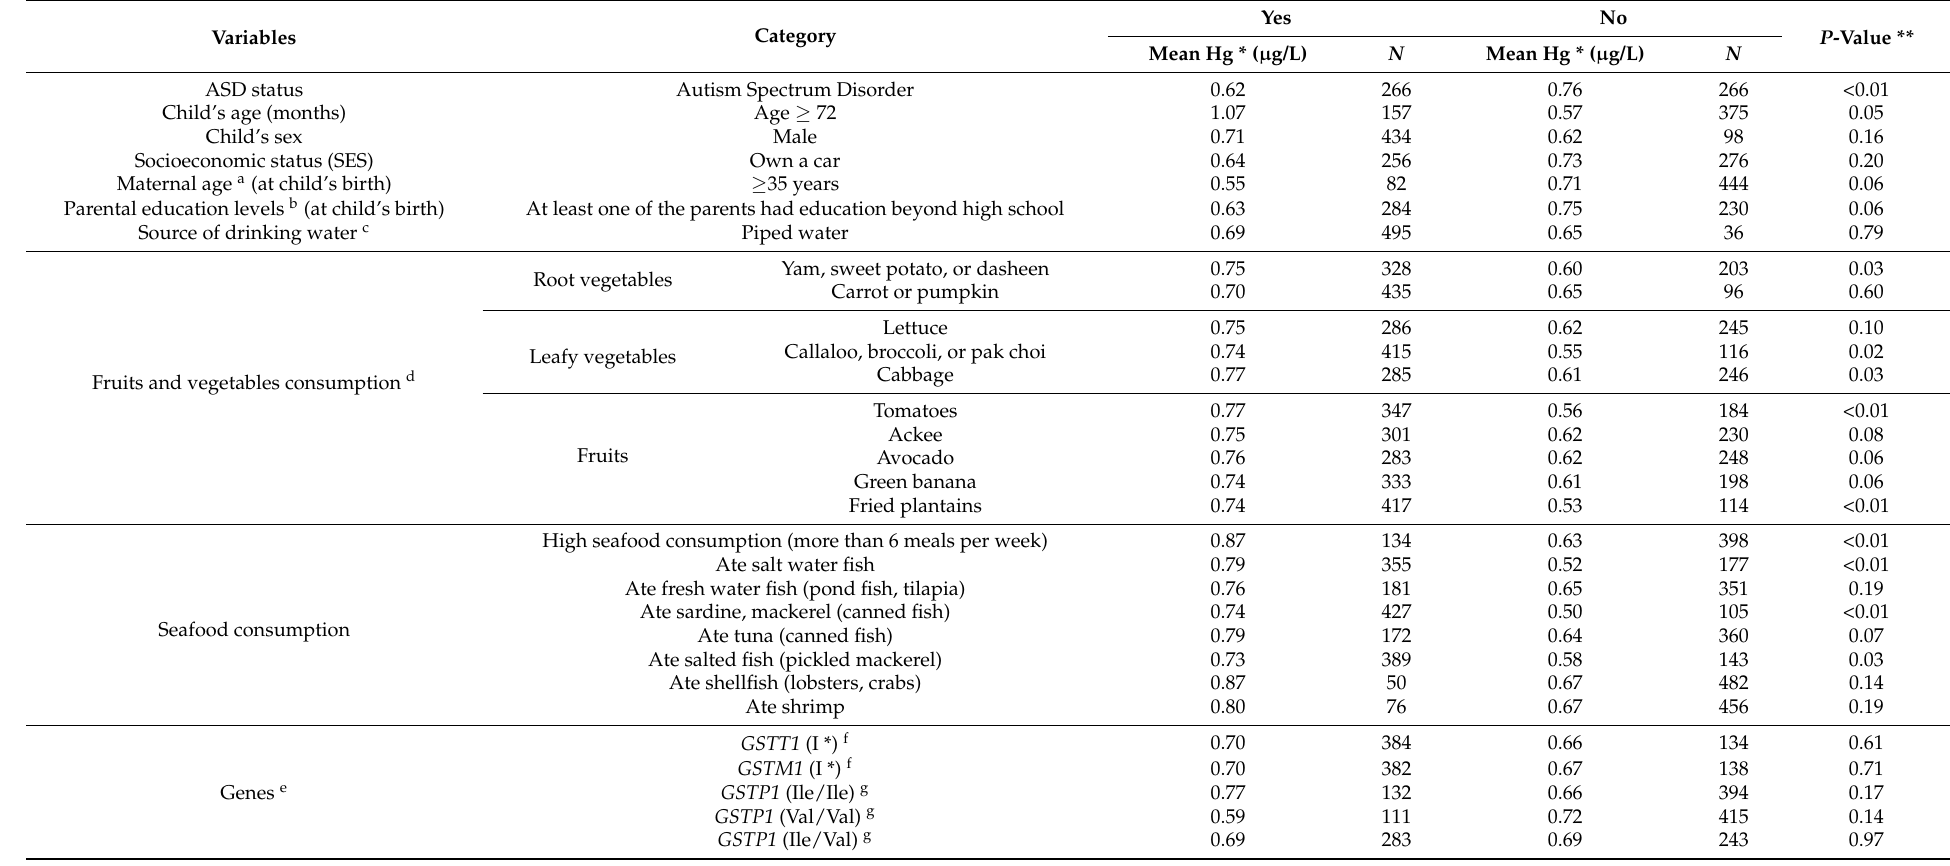
Table 3. Associations of various independent variables with blood mercury concentrations based on univariable General Linear Models (266 matched pairs).